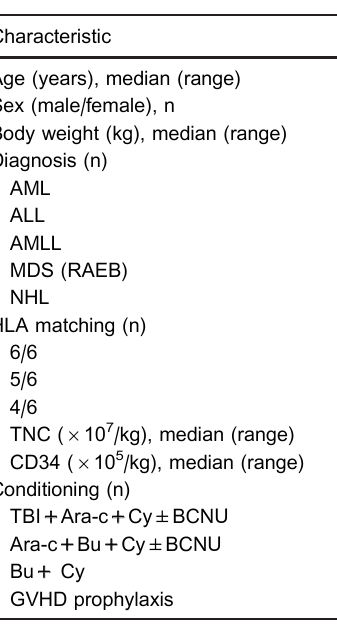
Table 1. Patient and transplant